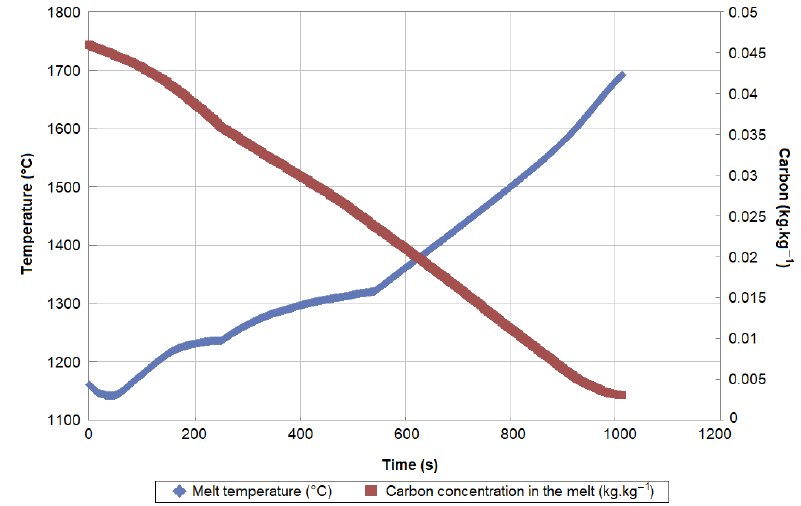
Figure 1. Model-based simulation of temperature and carbon in melting